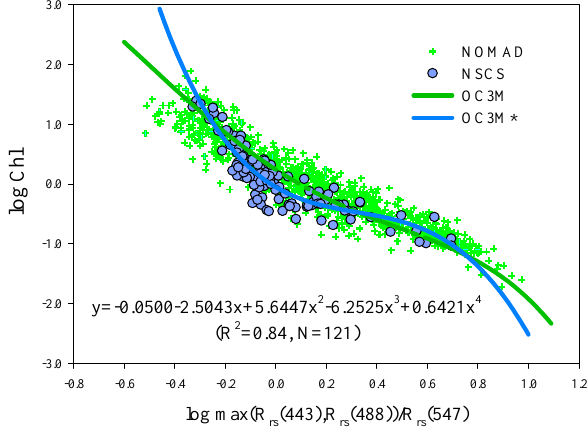
Table 2. Coefficients of a ∗